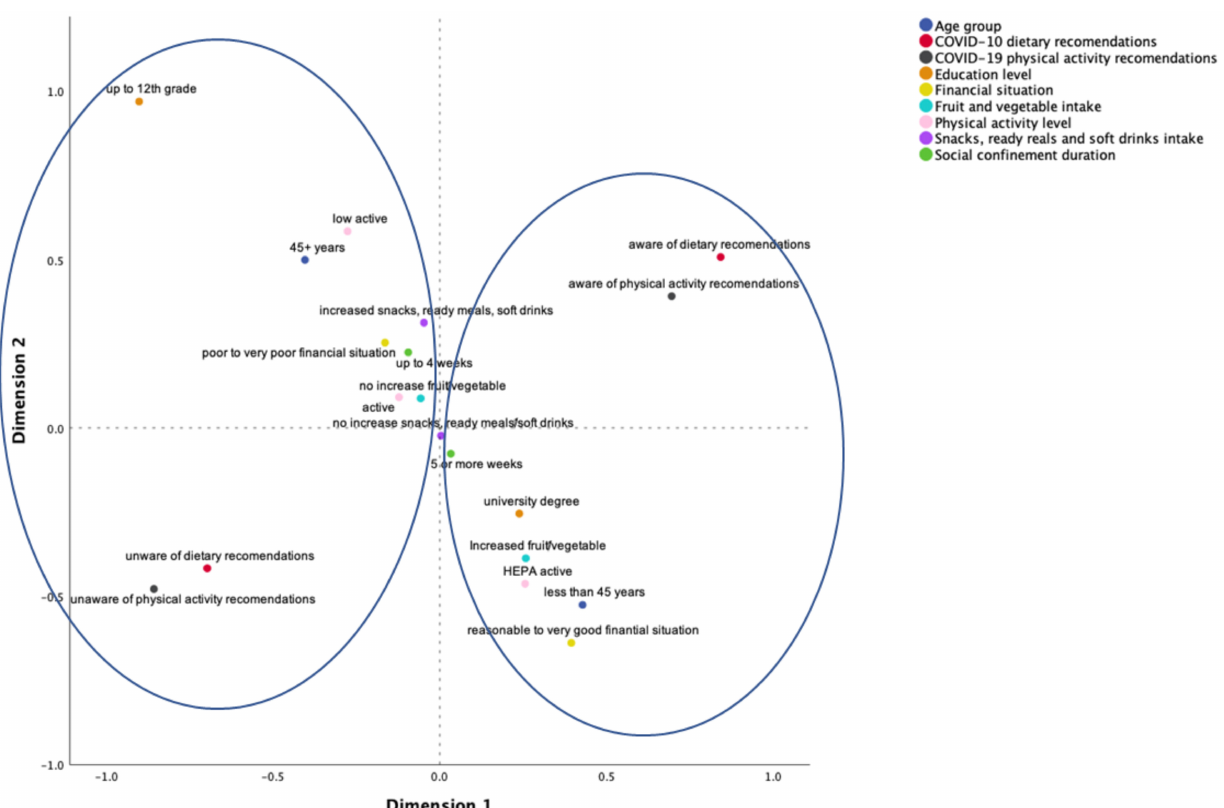
Figure 2. Health vs. risk